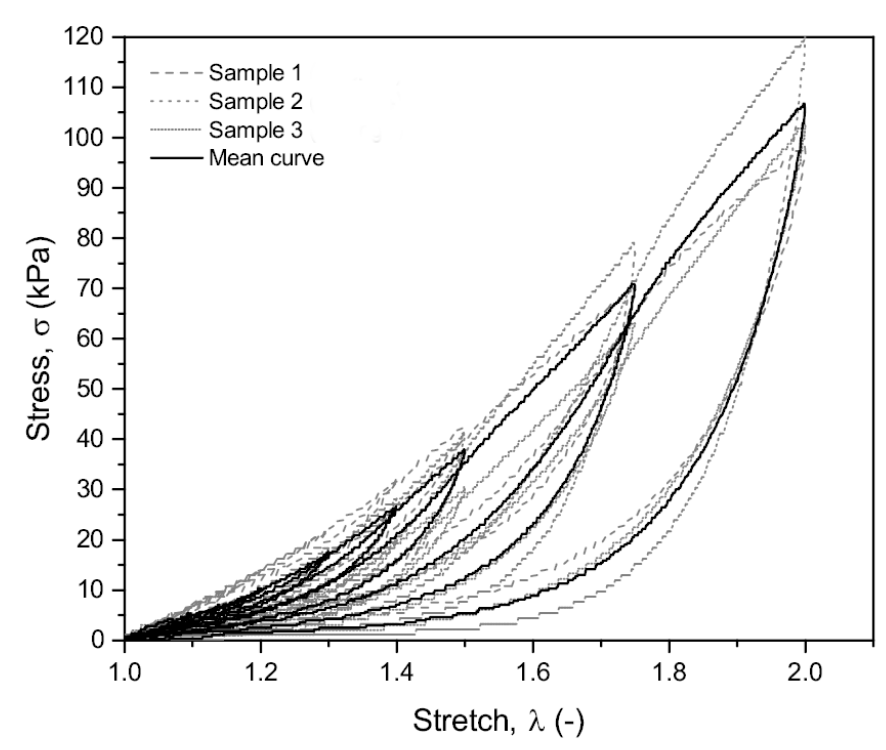
Figure 6. Experimental results and mean curve corresponding to the longitudinal samples from porcine urethra.